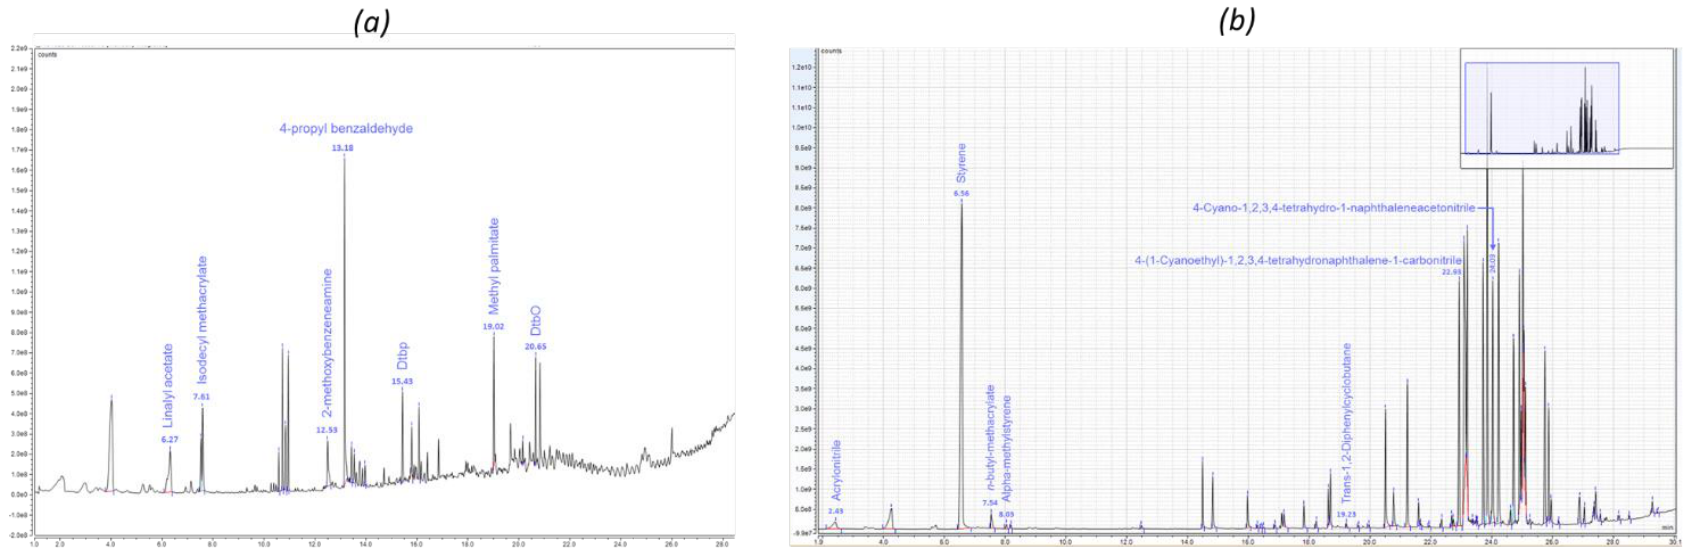
Figure 2. Chromatograms obtained by Pyr-GC-MS for ( a ) packaging P2 (100% PP) and ( b ) packaging P3 (100% styrene-acrylonitrile copolymer (SAN)).